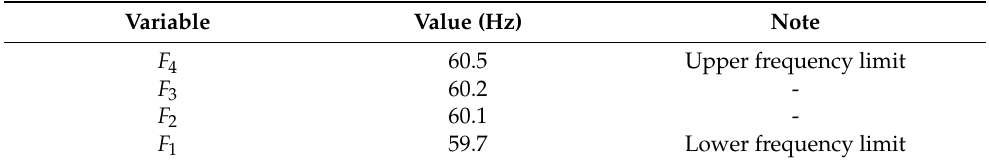
Table 4. EMS configuration for operation in frequency control mode .